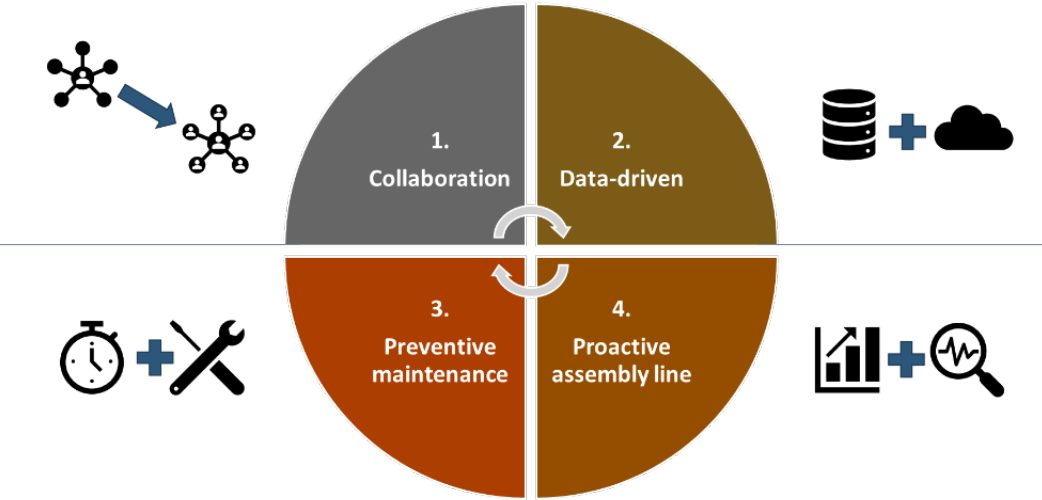
Figure 5. Key characteristics of the Smart Assembly Line.